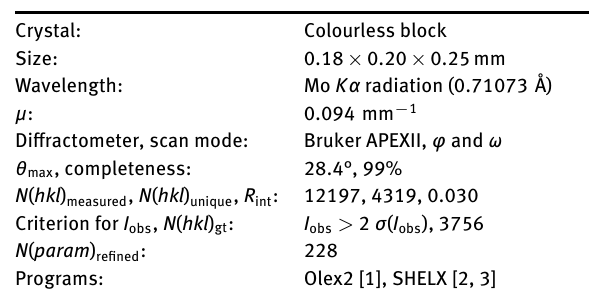
Table 1: Data collection and handling.